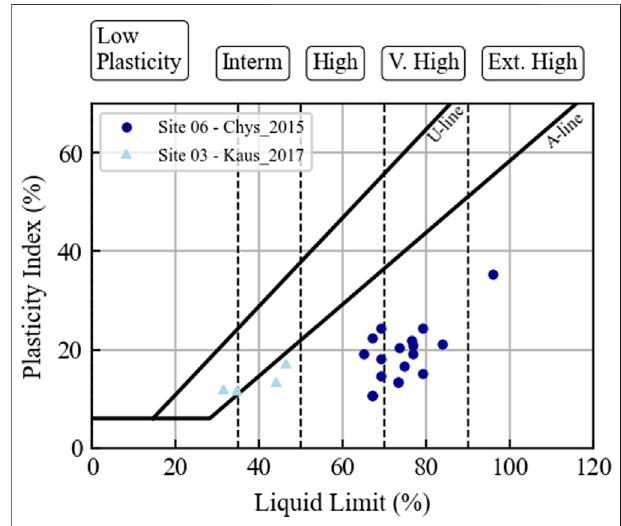
FIGURE 10 | Casagrande soil classi fi cation chart site 06-Chyasal (Chys_2015) (SAFER/GEO-591; Gilder et al., 2019a; Gilder et al., 2020) at 1.5 – 12.0 m depth and site 03-Kausaltar up to 4.0 m